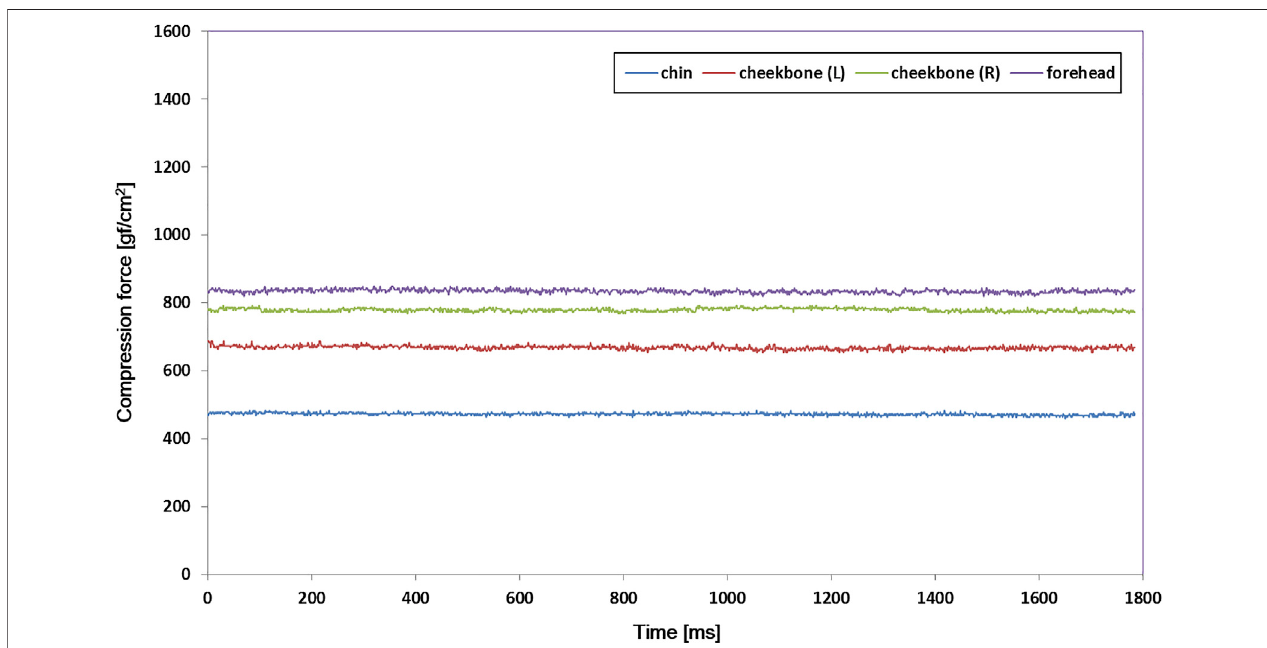
FIGURE 6 | Compression force variations at four measuring spots inside the thermoplastic mask with a rigid head phantom for a 3-min trial. The output signal was maintained stable in all of the sensors.